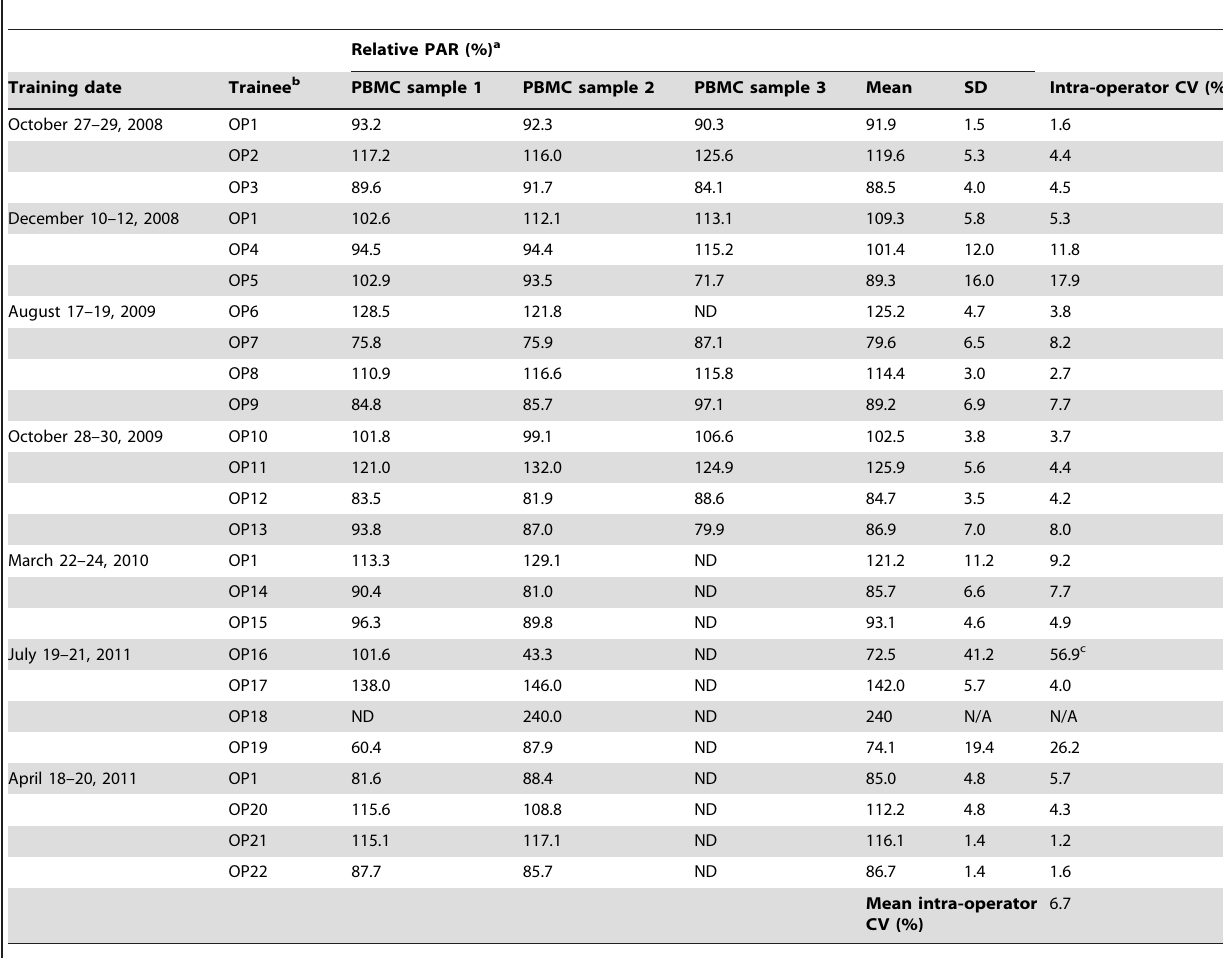
Table 3. Longitudinal comparison of PAR immunoassay training course PAR readout levels in PBMCs from healthy